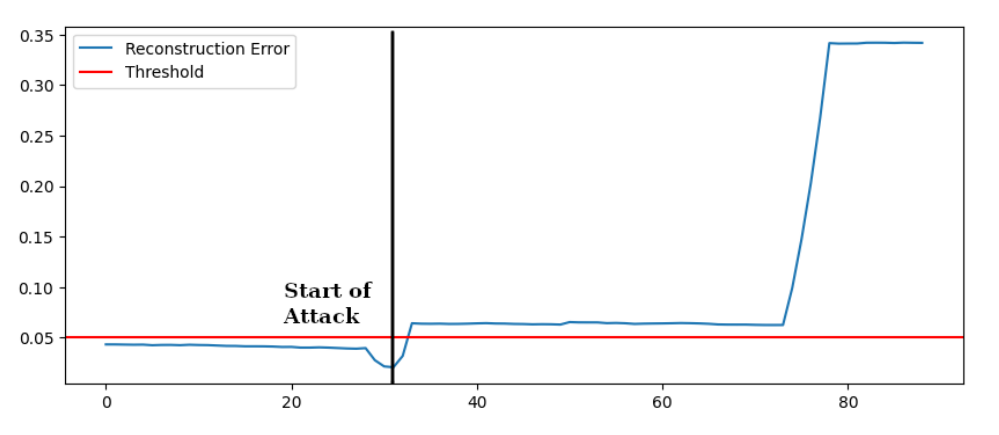
Figure 7. Reconstruction Error—Unusual Behavior. Table 3. Tests—Partial Attack.